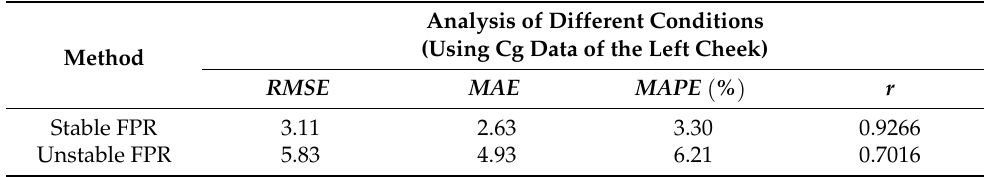
Table 1. Comparative results of the FPR on stable and unstable datasets.